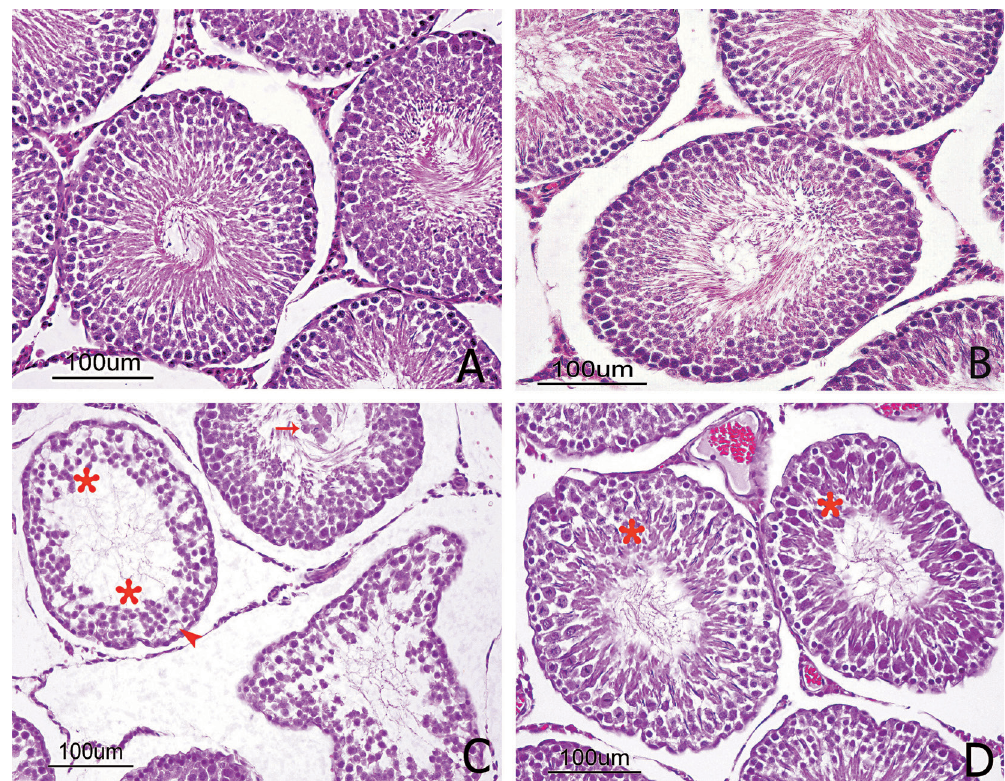
FIGURE 1 - Histopathological appearance of cross-sections of the rat testes. (A) Control and (B) SMN groups showed normal seminiferous tubule morphology and spermatogenic cells in advanced stages. Additionally, all germ cells were present and appeared normal. (C) The testes of the MTX group showed atrophy of the seminiferous tubules and arrested spermatogenesis (stars). The seminiferous tubules were irregular and had only Sertoli cells and spermatogonia. Vacuolization was apparent in the germ and Sertoli cells (arrowhead) with desquamated immature cells in the lumen of the seminiferous tubules (arrow). (D) In the testes of the MTX + SMN group, the morphology of the seminiferous tubules was almost normal. The spermatogenic cells in the seminiferous tubules (stars) continued spermatogenesis in a manner that included spermatozoa (H&E, 200x). TABLE II - Quick scores for GPx1 and SOD2 immun expression in testis tissue of rats